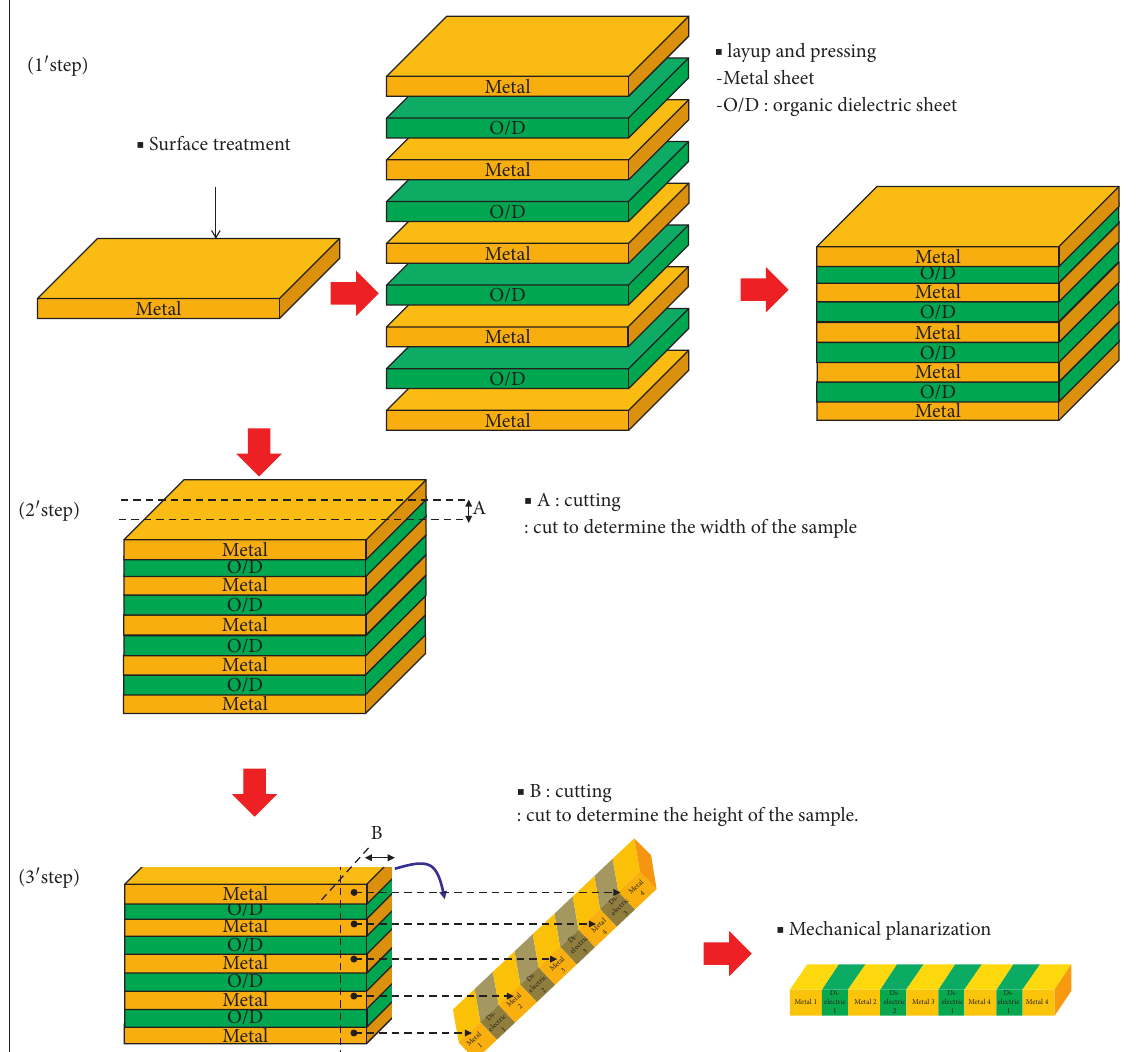
Figure 3: The fabrication method of the horizontal array capacitor with the PPG dielectric